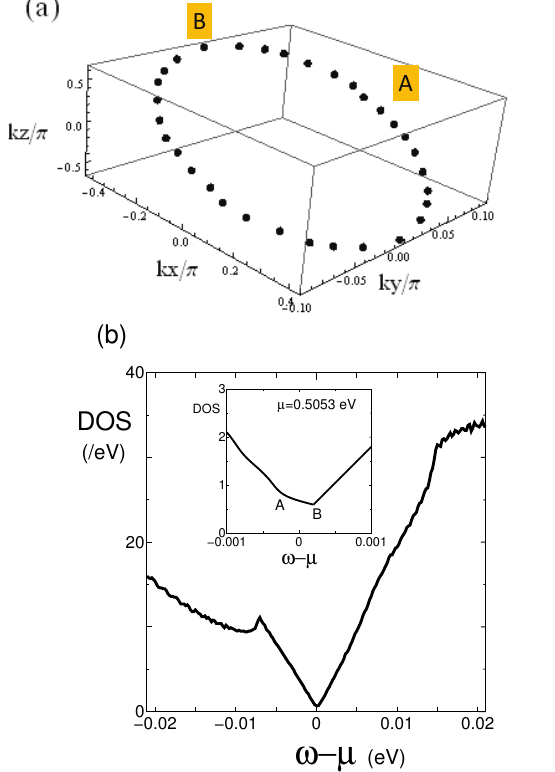
Figure 2. (Color online) ( a ) Nodal line in the three-dimensional momentum space, which connects Dirac points (symbols). ( b ) Density of states (DOS), as a function of ˜ ω = ω − µ with µ = µ ( 0 ) = 0.5053 eV. The inset denotes the behavior close to ˜ ω = 0, where A (B) corresponds to k z / π = 0 ( the maximum of | k z / π | in the